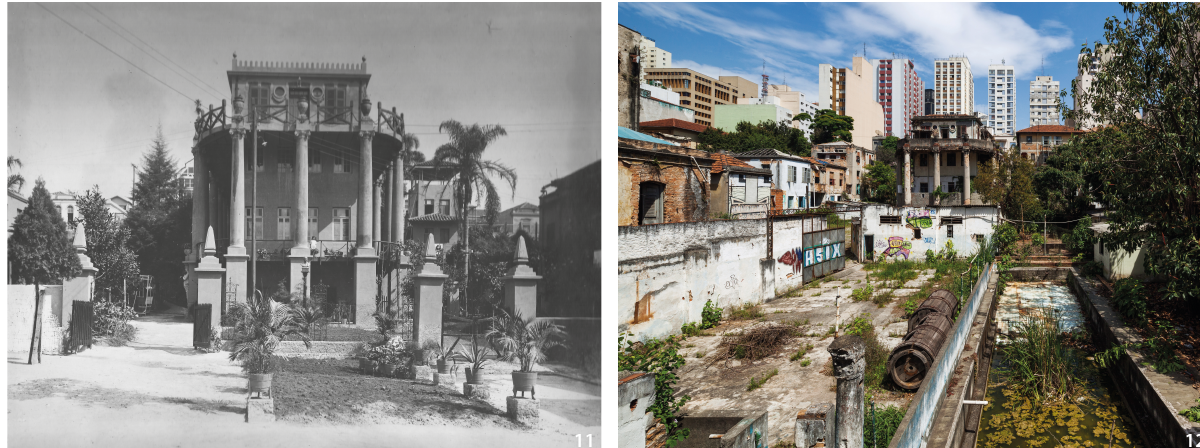
Figure 11 Vila Itororó circa 1930 (Source: Acervus Milu Leite, date unknown). Figure 12 Vila Itororó before restoration (Source: Nelson Kon,